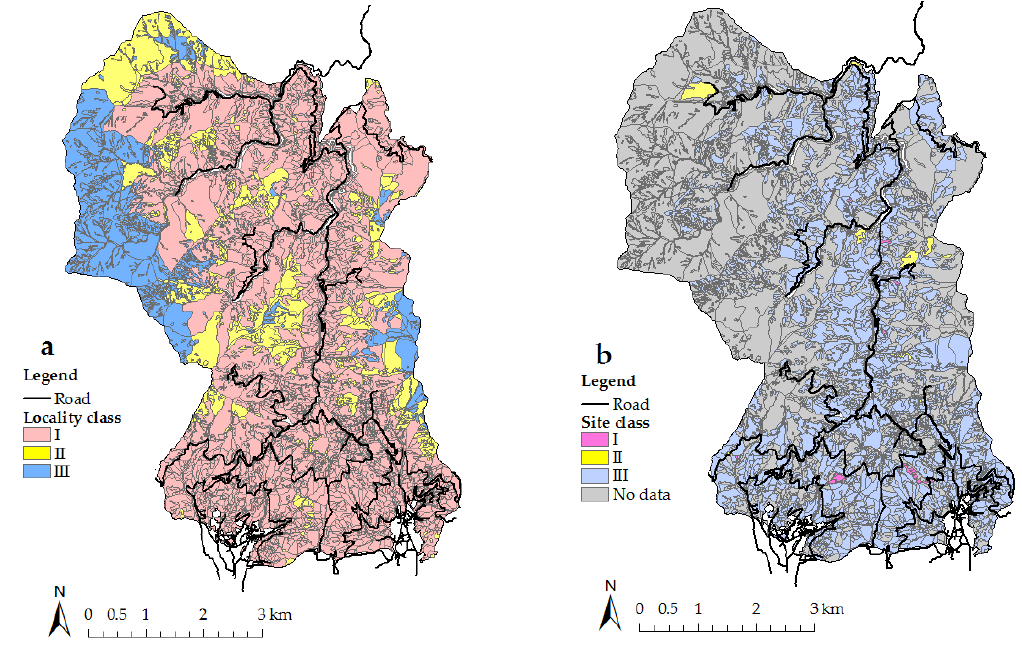
Figure 9. Locality (distance to road) ( a ) and site classes ( b ) in the study area.